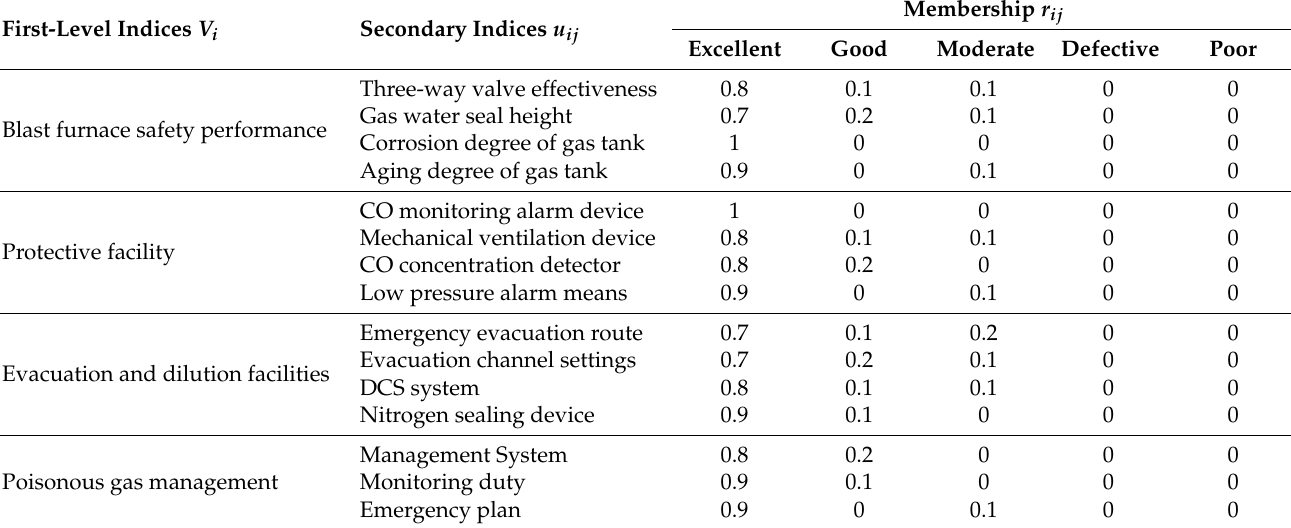
Table 2. Fuzzy membership matrix of toxic gas leak risk.